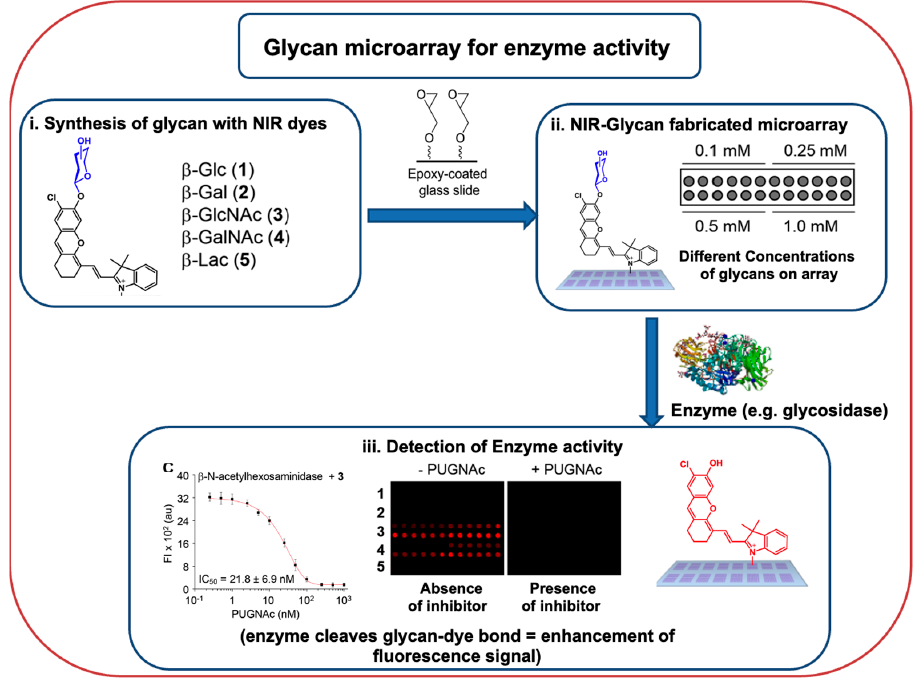
Figure 4. A generic workflow of the application of glycan microarray chip to efficiently profile enzyme activities and determine enzyme inhibitor IC 50 values ([62]). enzyme activities and determine enzyme inhibitor IC 50 values